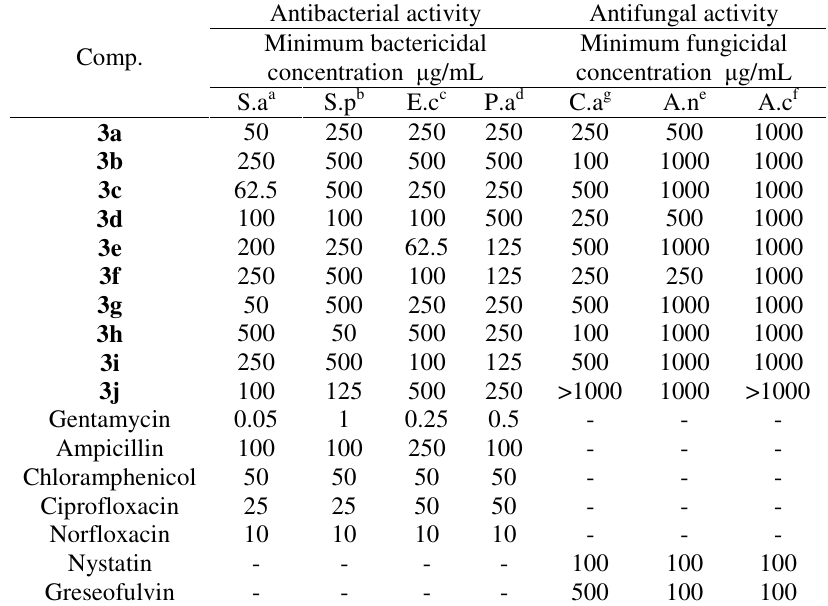
Table 2. Antimicrobial activity of compounds (